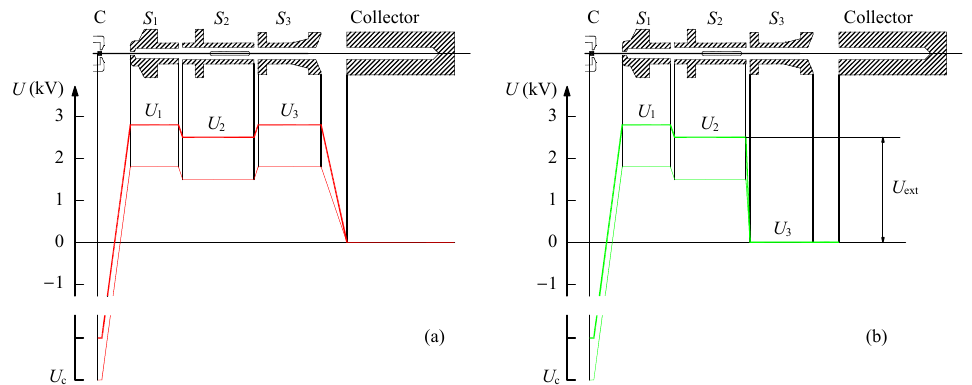
Figure 3. Schemes of electric potential distribution along the drift tube: C, cathode; U c , cathode potential; U ext , extraction potential; potentials U 1 , U 2 , and U 3 are applied to the drift tube electrodes S 1 , S 2 , and S 3 , respectively. ( a ) Regime of axial trapping: the edge sections of the drift tube are positively biased with respect to the middle section to form the axial potential barriers. ( b ) The ion extraction regime is controlled over time by switching the potential U 3